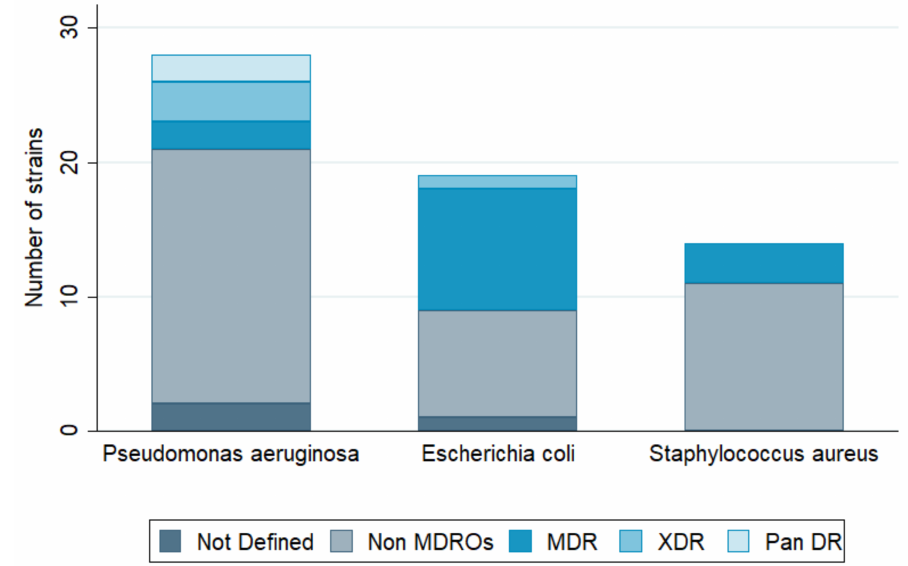
Figure 5. Proportion of drug-resistant strains in the three most prevalent bacterial pathogens (see also Supplementary Table S1). MDR, multidrug-resistant; non-MDROs, non-multidrug-resistant organisms; Pan DR, pandrug-resistant; XDR, extensively